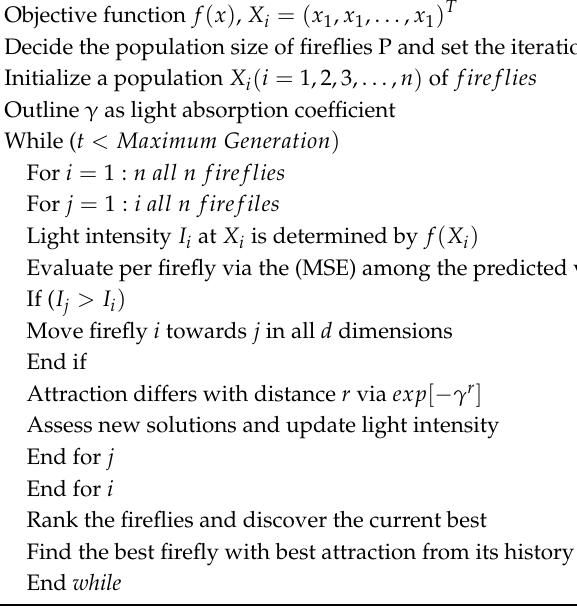
Algorithm 1. Firefly Algorithm